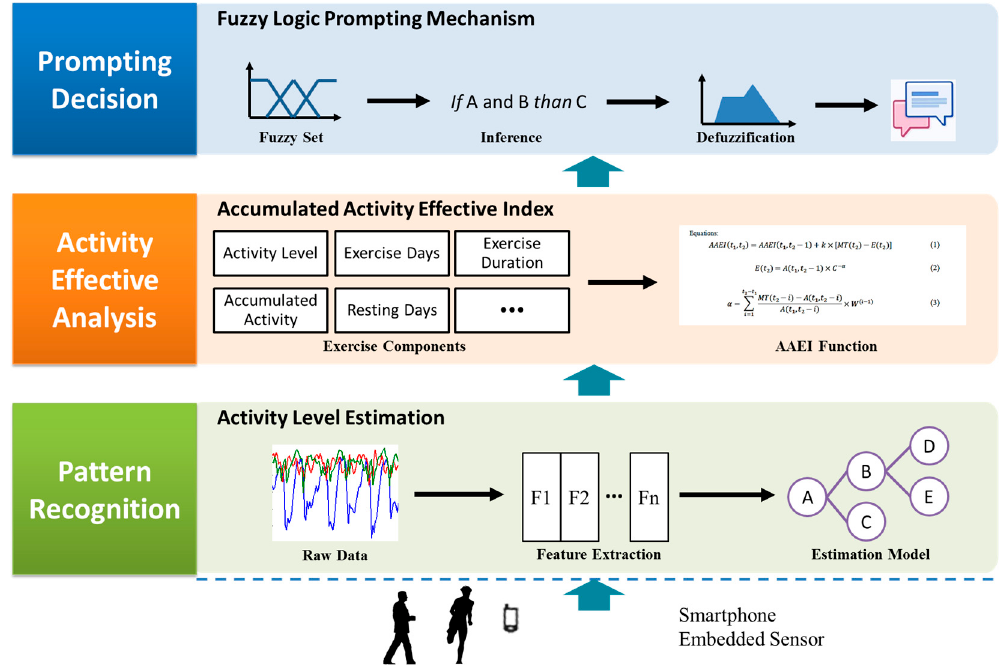
Figure 1. Platform of fuzzy logic prompting mechanism implemented in a .smartphone.